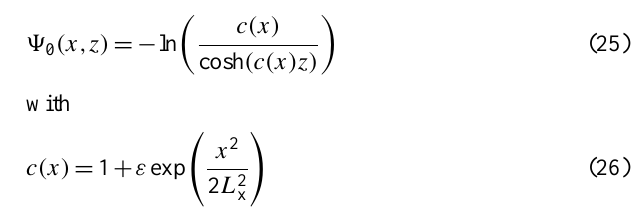
Figure 9 proposes the result of a run: the left column rep- resents the thermal pressure fluctuations and the right col- umn the magnetic pressure fluctuations as contour plots in the (x,z)-plane for three values of time t = 16 , 32 , 48 , 64 and 80. While the pressure eigenmodes develop and propagate freely towards the positive x-direction, they are